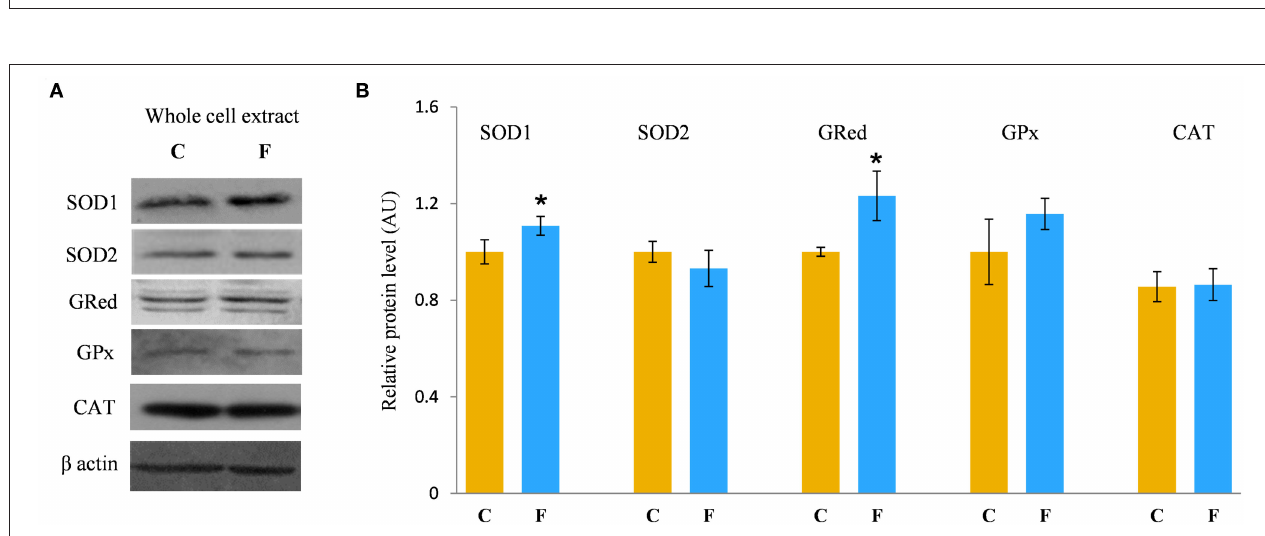
FIGURE 8 | Antioxidative enzymes in the VAT of female rats fed with 10% fructose diet for 9 weeks. Representative Western blots (A) of the protein levels of SOD1, SOD2, GRed, GPx, and CAT (B) were measured by Western blot in the whole cell extracts of the VAT from control (C) and fructose-fed (F) rats, normalized to β actin and expressed in AUs. The values represent the means ± SEM ( n = 8 animals per group). Statistical significance of the difference between experimental groups (Student’s t -test): * P < 0.05, F vs. C.